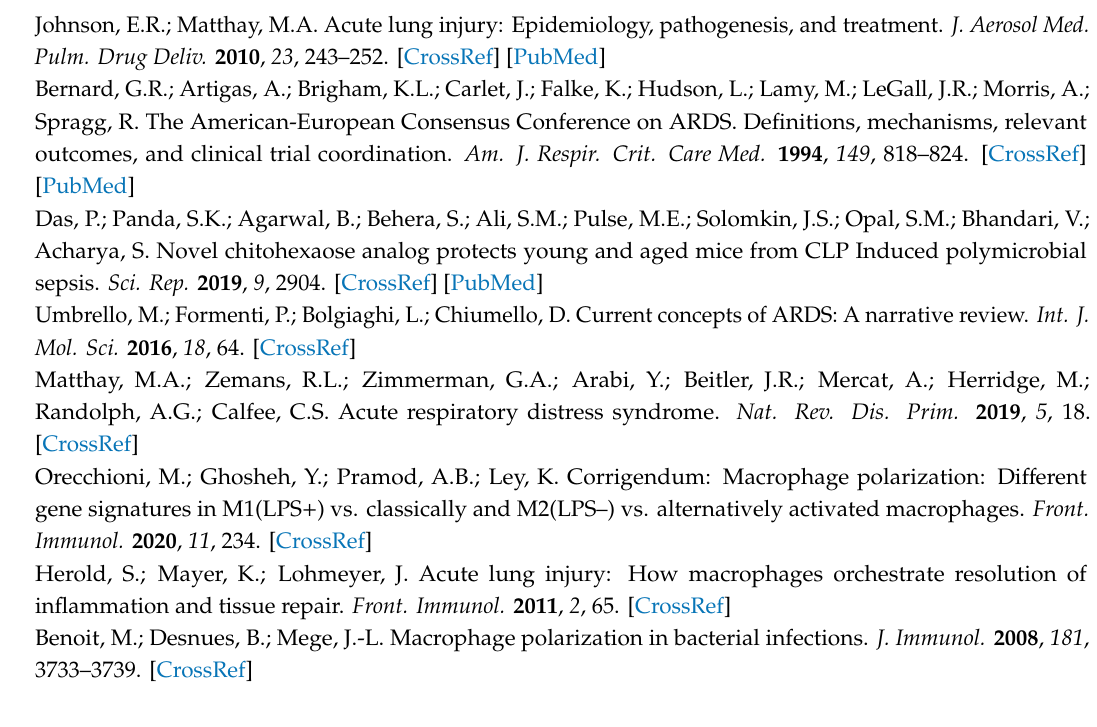
Figure S1: (A) NO secretion of transfected RAW264.7 cells after LPS stimulation, (B) NO secretion of transfected RAW264.7 cells after IL-4 treatment, Table S1: List of all di ff erentially expressed genes